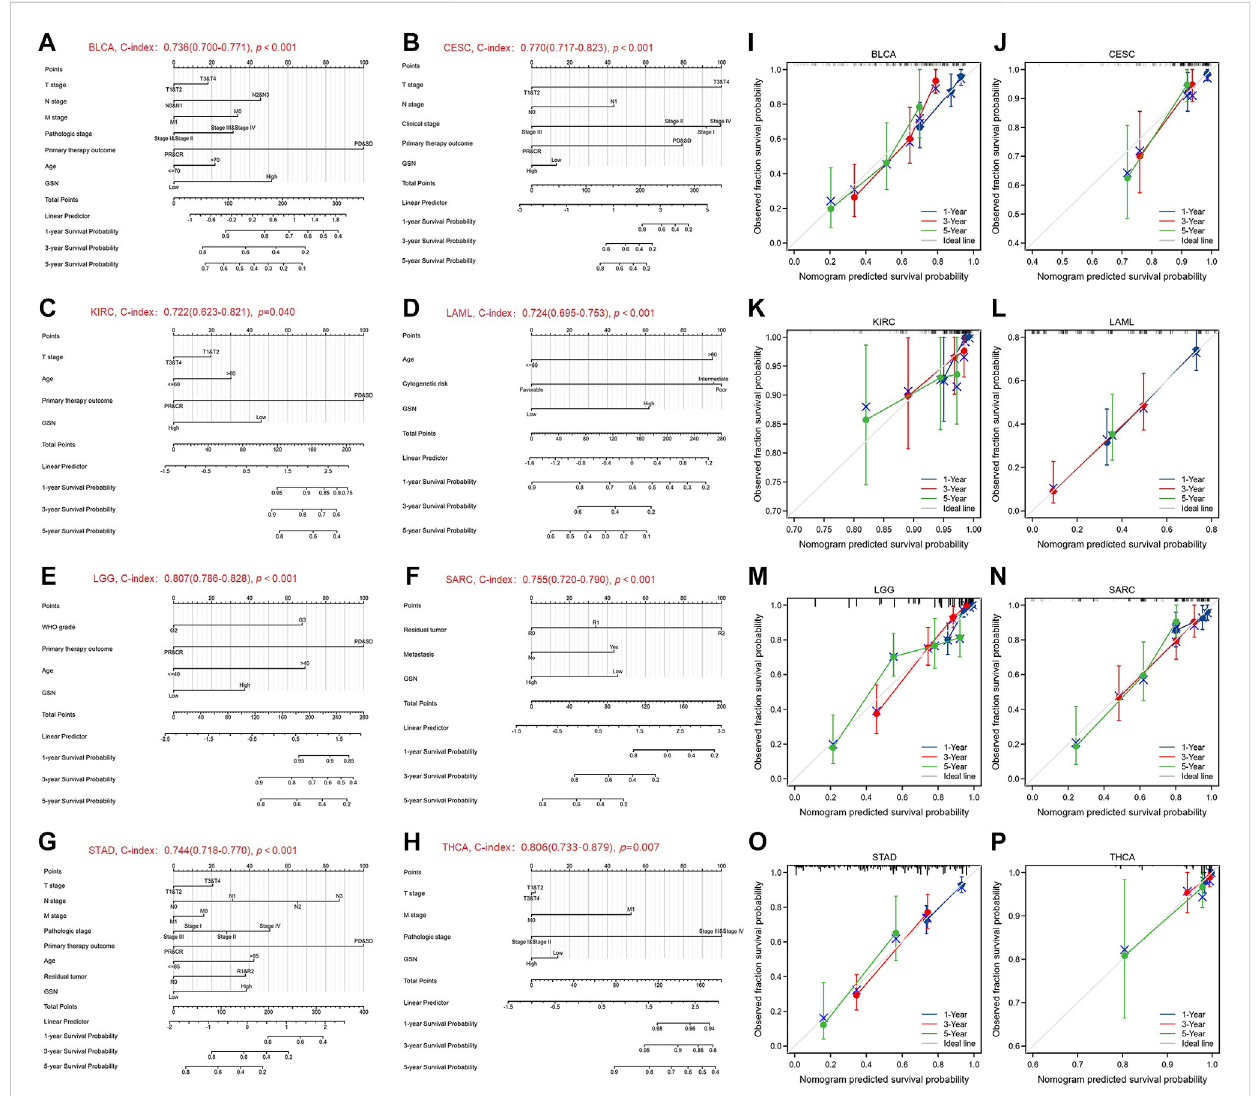
FIGURE 6 Nomograms and calibration curves predicting patient OS in 8 cancers. Nomograms of BLCA (A) ; CESC (B) ; KIRC (C) ; LAML (D) ; LGG (E) ; SARC (F) ; STAD (G) ; THCA (H) . Calibration curves of BLCA (I) ; CESC (J) ; KIRC (K) ; LAML (L) ; LGG (M) ; SARC (N) ; STAD (O) ; THCA (P) . The horizontal and vertical coordinatesare themodel predicted and actually observed survivalprobability, respectively. The closer eachline is to theideal line,the better